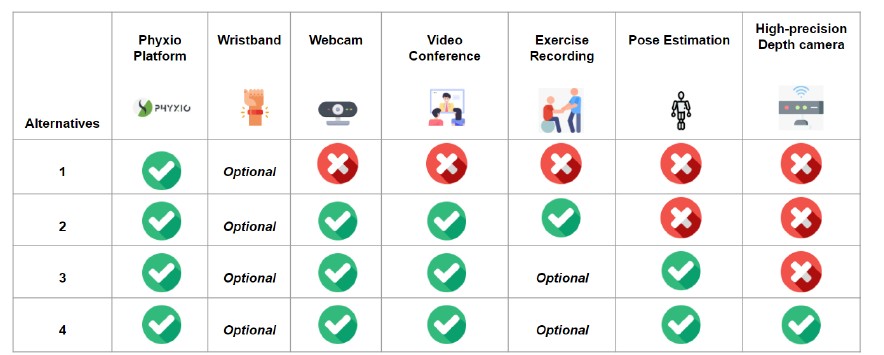
Figure 1. Characteristics of each